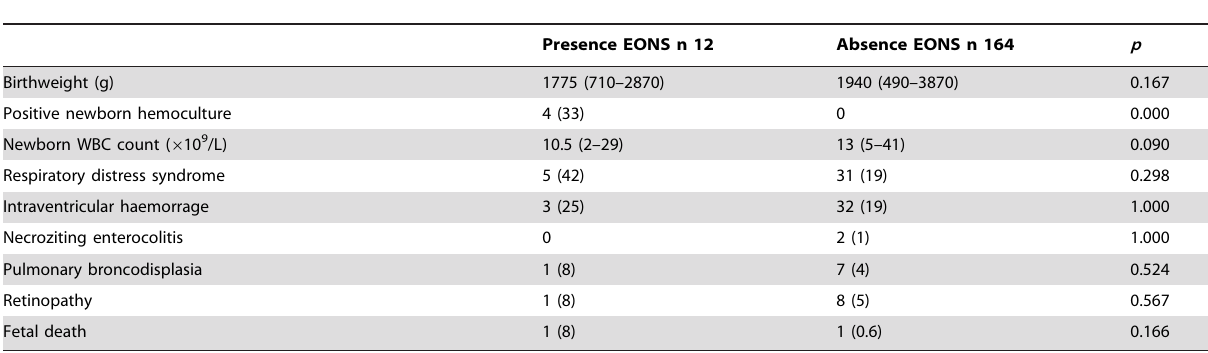
Table 2. Neonatal outcomes according the presence or absence of early-onset neonatal